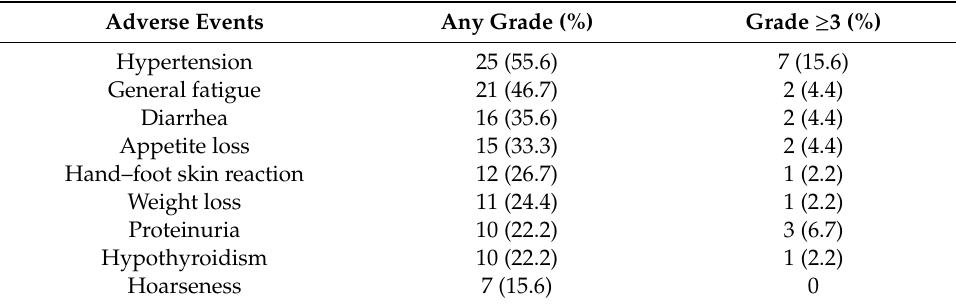
Table 4. Adverse events (>10%).